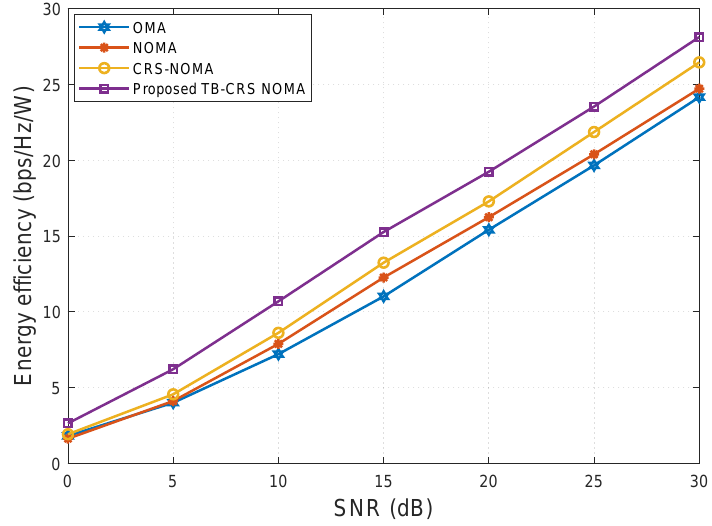
Figure 8. Energy efficiency versus SNR for K = 32 MUTs.